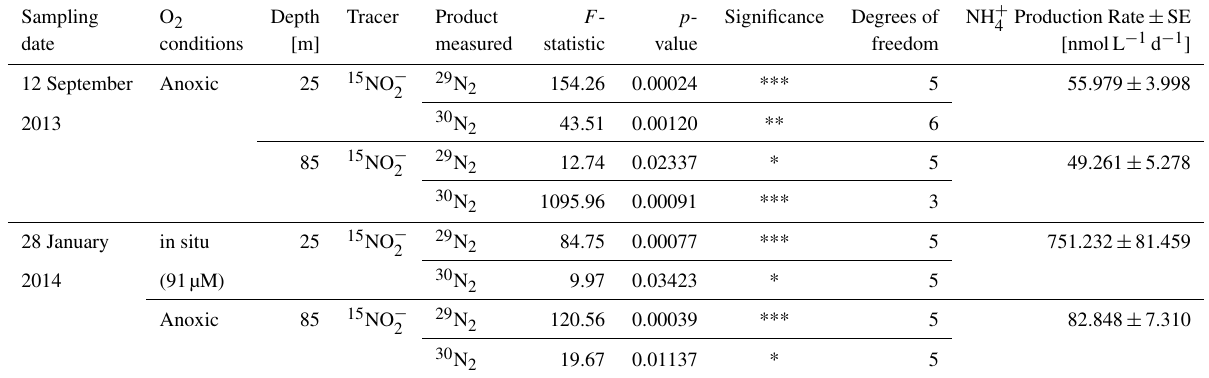
Table 4. Experimental dates, oxygen conditions during the incubations, tested depths, tracers amendments, pairing labelled N 2 product measured, summary of the Student’s t test used to evaluate the significance of the activity obtained, and ammonium production rates (DNiRA) measured as 29 / 30 N 2 after chemical